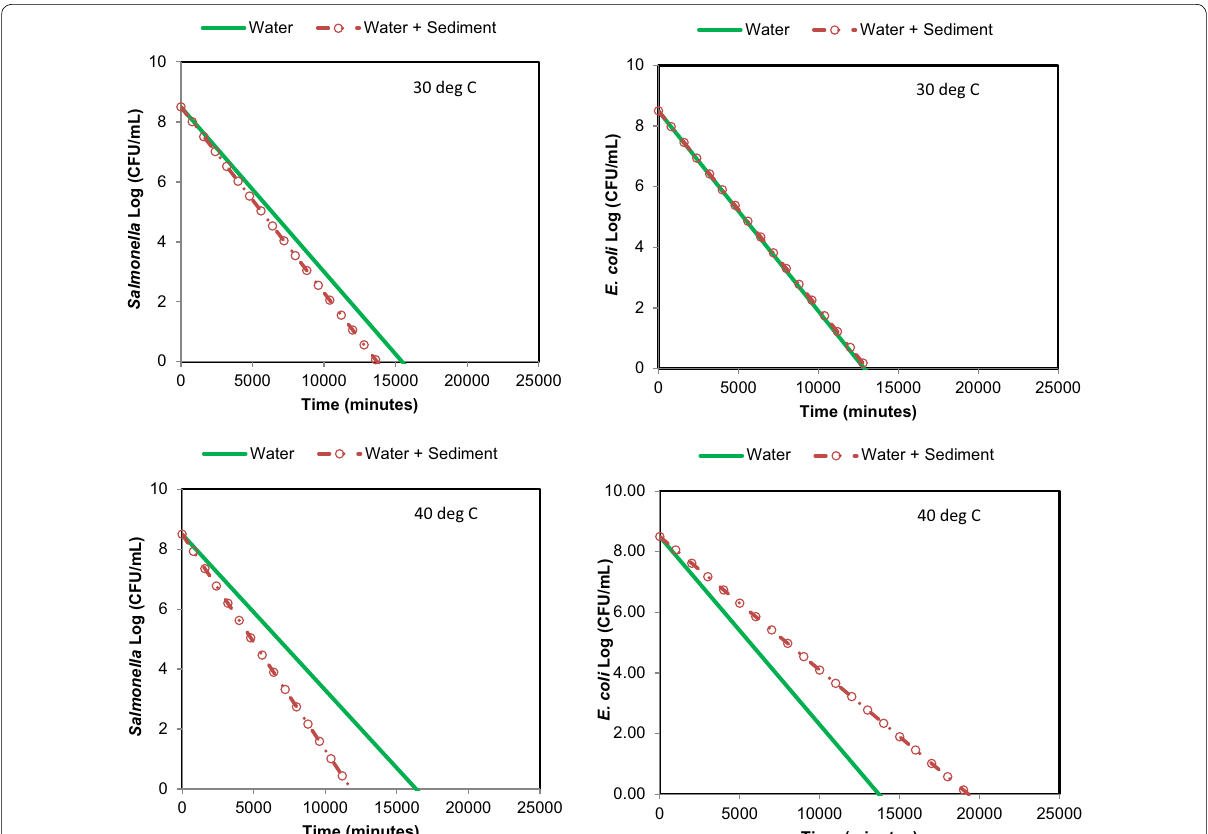
Fig. 7 Decay curves of E. coli O157:H7 and Salmonella at 30 and 40 °C under free floating and particle attached conditions (curves shown are the average of curve for Run 1 and curve for Run 2; equations are shown in Table